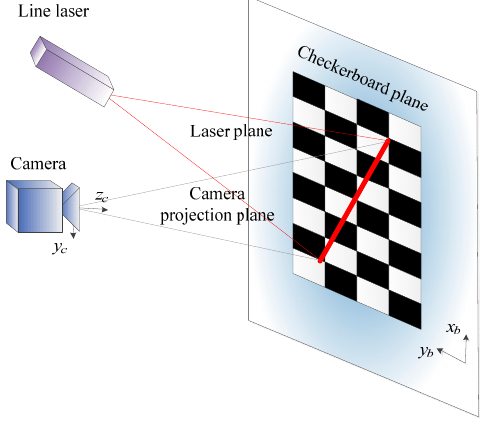
Figure 2. Line-structured light and camera calibration.